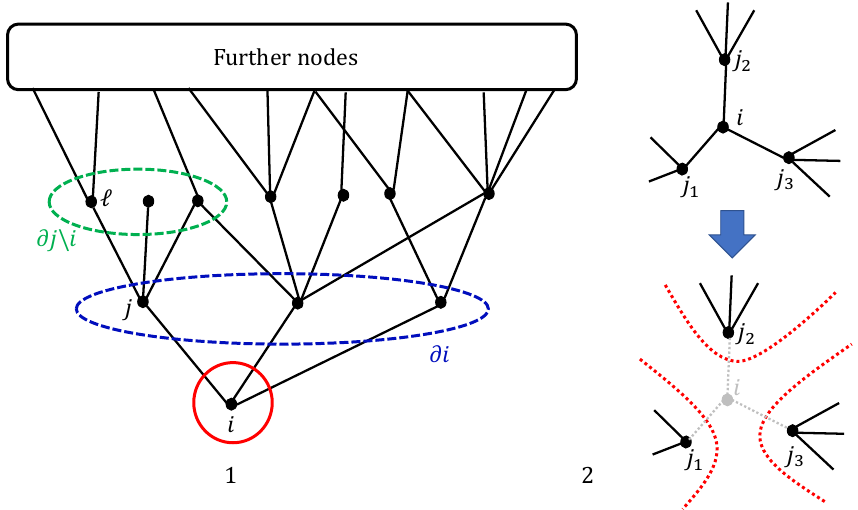
Figure 1: Graph sketches. Graph 1 : a tree-like graph where the indices refer to the notation used in Section 3.1 to derive cavity single-instance equations. Graph 2 : example of the decorrelation occurring to the nodes j node i , after the removal of i